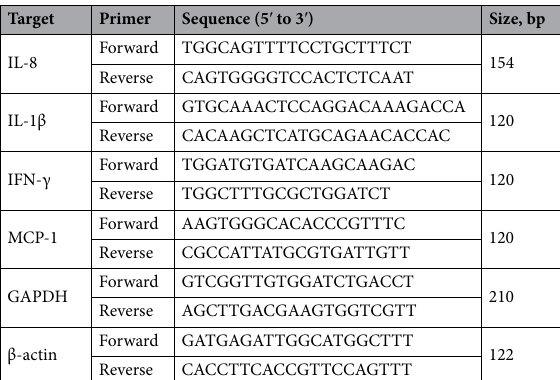
Table 2. Sequence of oligonucleotide primers used for